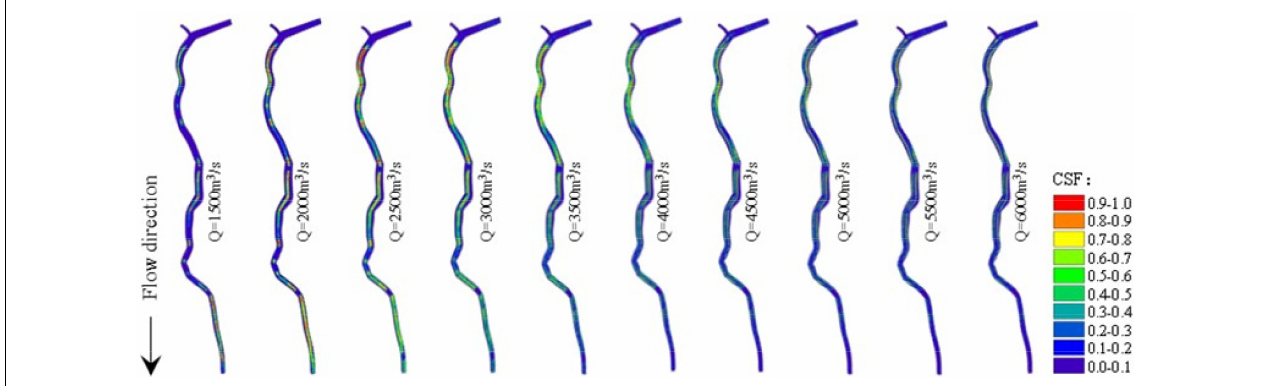
FIGURE 7 | Spatial distribution of the combined suitability factor (CSF) in different outflows from the Xiangjiaba Reservoir.